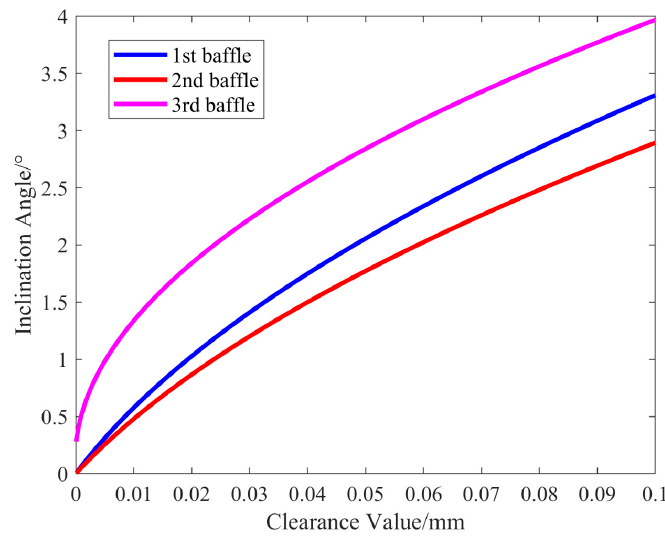
Figure 11. Each sub-baffle inclination with different clearance